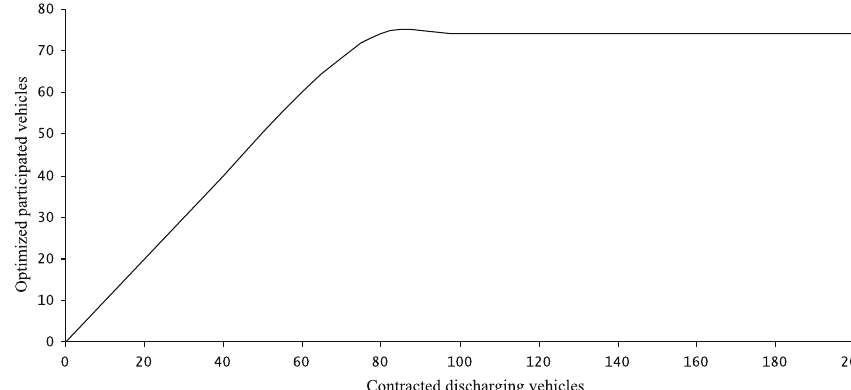
Fig. 13 Optimal participated number under different volunteered